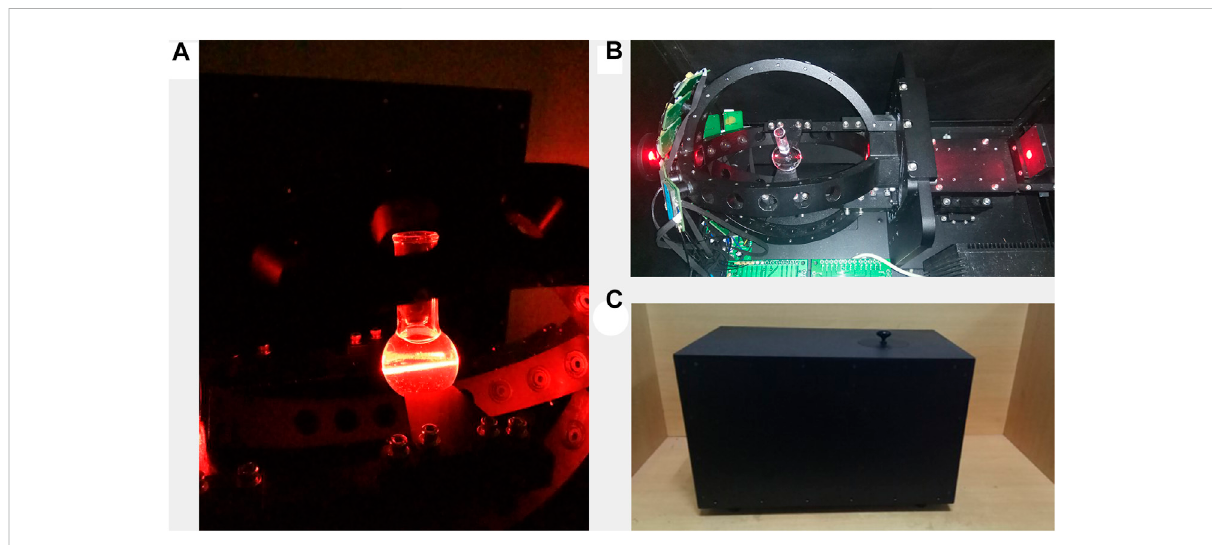
FIGURE 6 (A) Internalstatus oftheprototype duringtheoperation; (B) photodetectorsare distributed inthebackwarddirection;and (C) an external cover of the system is used to avoid external light (dimension: 50 cm × 30 cm × 30 cm).